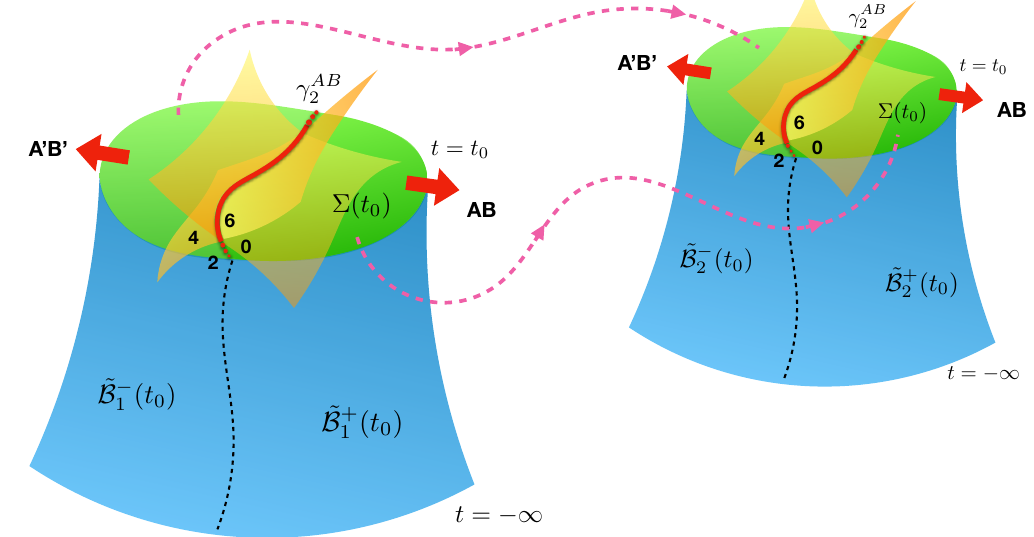
Figure 20 . Bulk Lorentzian saddle in the form of two Schwinger-Keldysh two-folds: ~ a = a ( t 0 ), glued at (cid:6)( t 0 ). The structure of Rindler wedges near the cosmic brane (cid:13) AB (cid:6) i =1 ; 2 i [ B